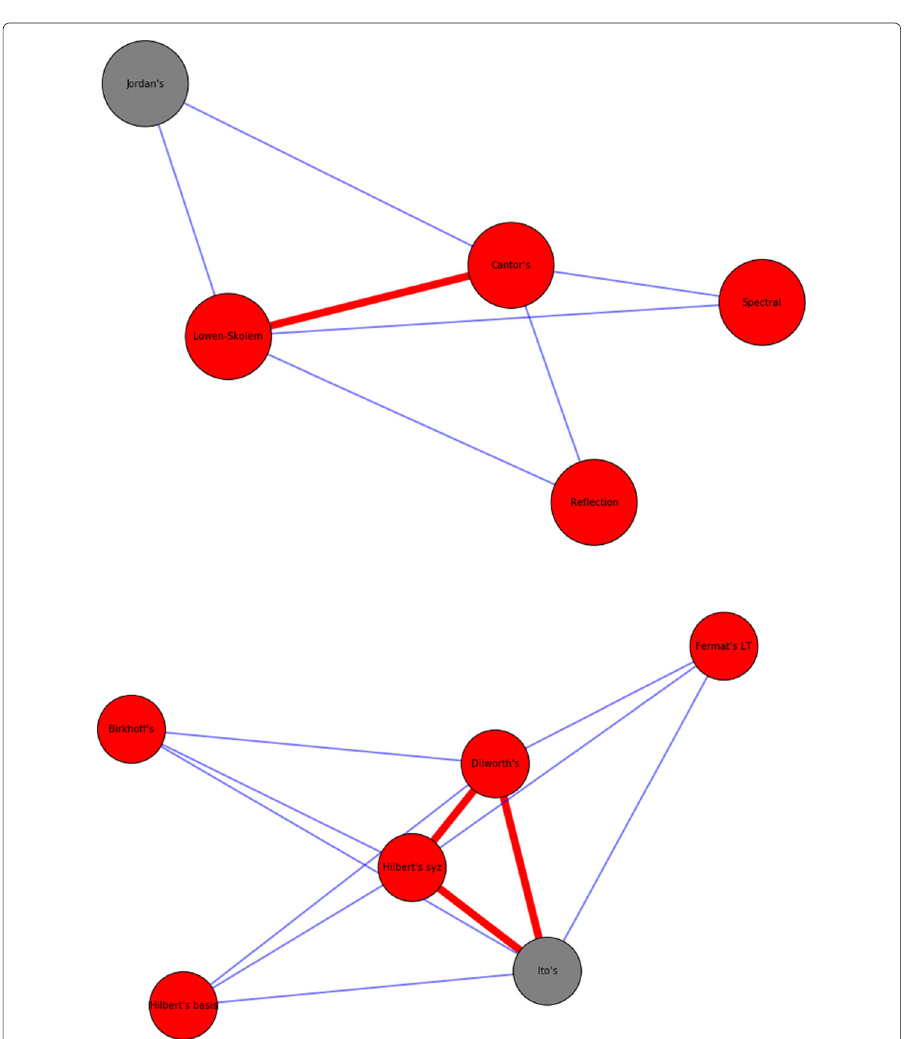
Fig. 2 Simplicial stars. Example of a S 2 3 (top) and a S 3 3 (bottom) star. Red nodes are theorem, grey nodes lemmas, while red edges delimit the simplices in core of the star